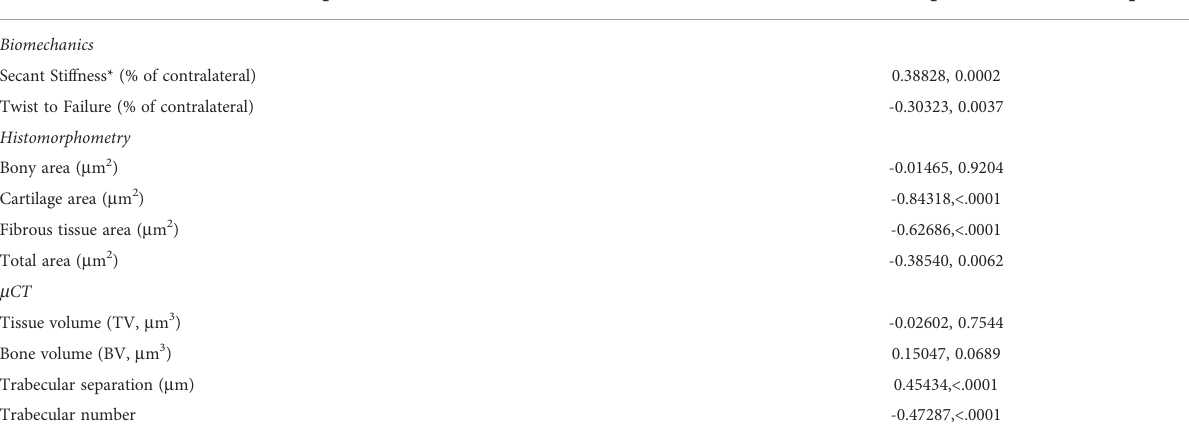
TABLE 2 Spearman correlation coef fi cients of mRUST and other fracture healing parameters over time. Standard Measures of Fracture